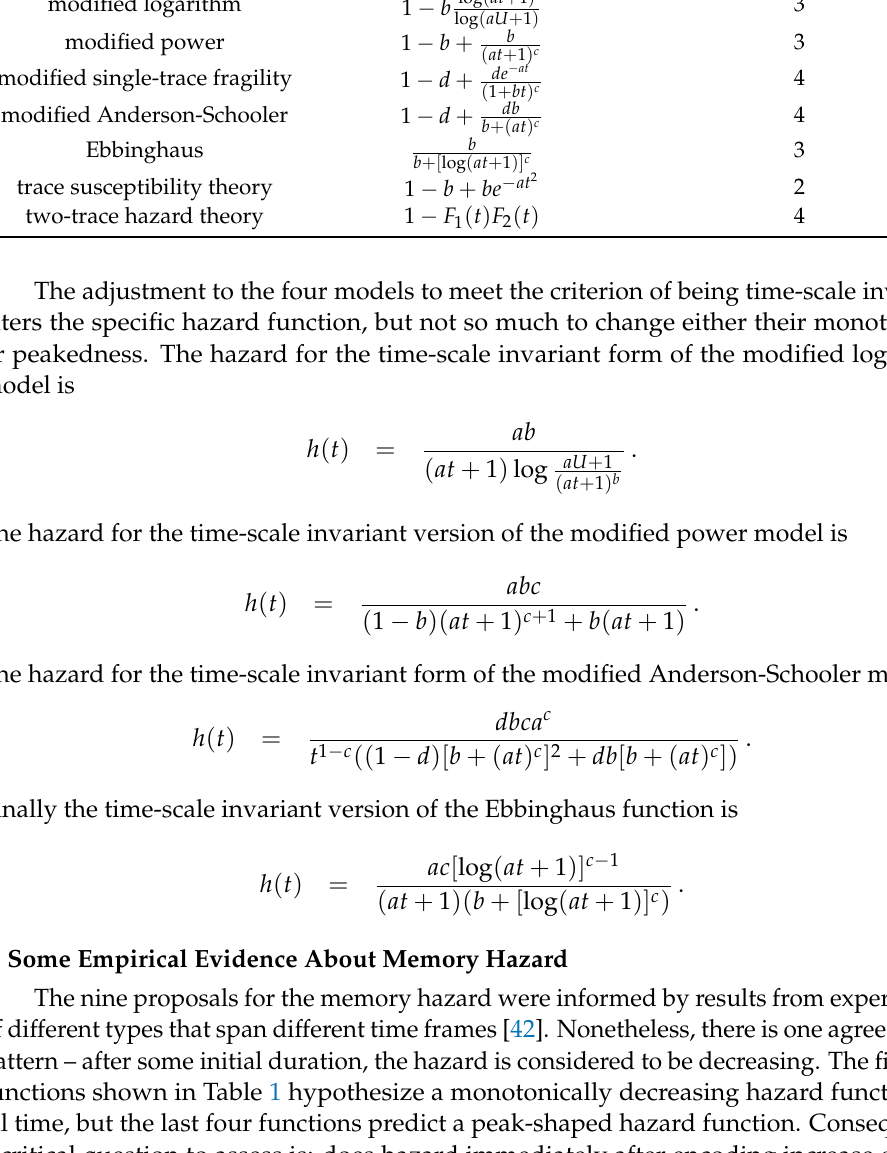
Table 2. The nine candidate models for the memory survivor function S ( t ) that are time-scale invariant. The parameters a , b , c and d are positive. The cumulative functions for the two respective traces of the two-trace hazard model are F 1 ( t ) = 1 − exp ( − d t 2 ) and F 2 ( t ) = b ( 1 − exp ( − at c ) . Model Name Survivor Function # Parameters modified